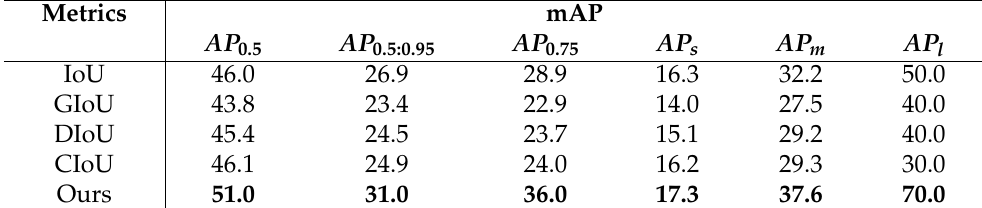
Table 3. Comparison of different metrics on Pest24 validation